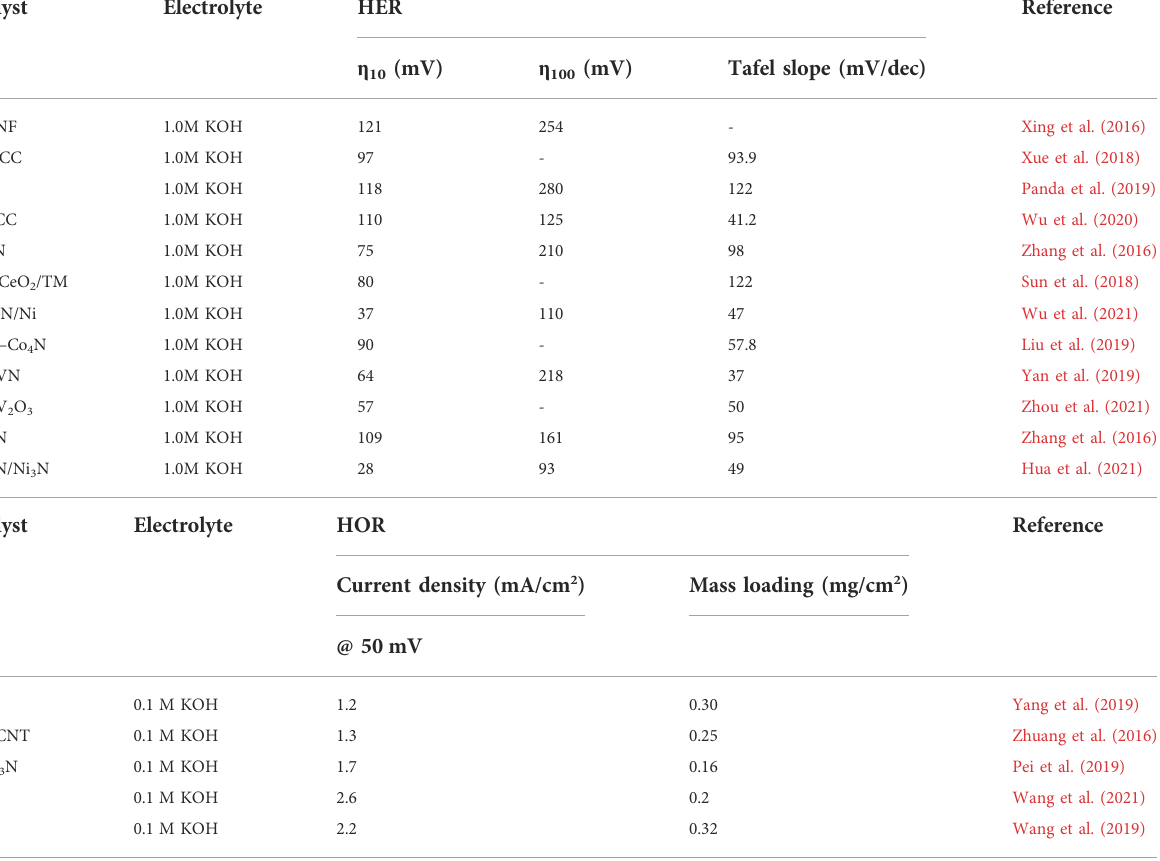
TABLE 1 Transition metal catalysts for the alkaline HER/HOR.